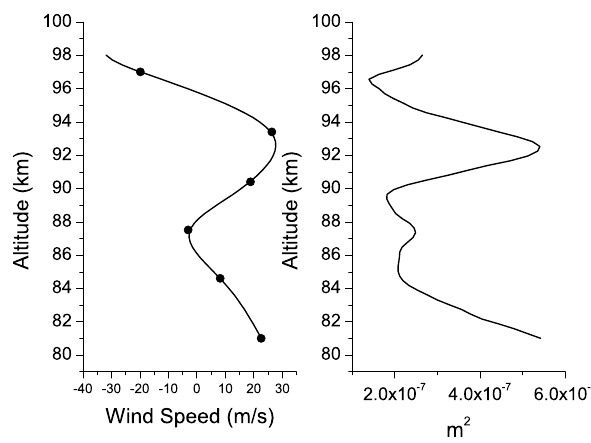
Fig. 16. Left plot shows the vertical wind profile (Esrange radar data) in the direction of wave 1 observed on 27/28 January at 16:00 UT. The sign indicates the direction of the wind relative to the wave motion (positive in the same direction). Right plot shows the squared value of the vertical wavenumber as a function of height. The positive value for m 2 throughout the emission layer heights is indicative of a freely propagating wave.